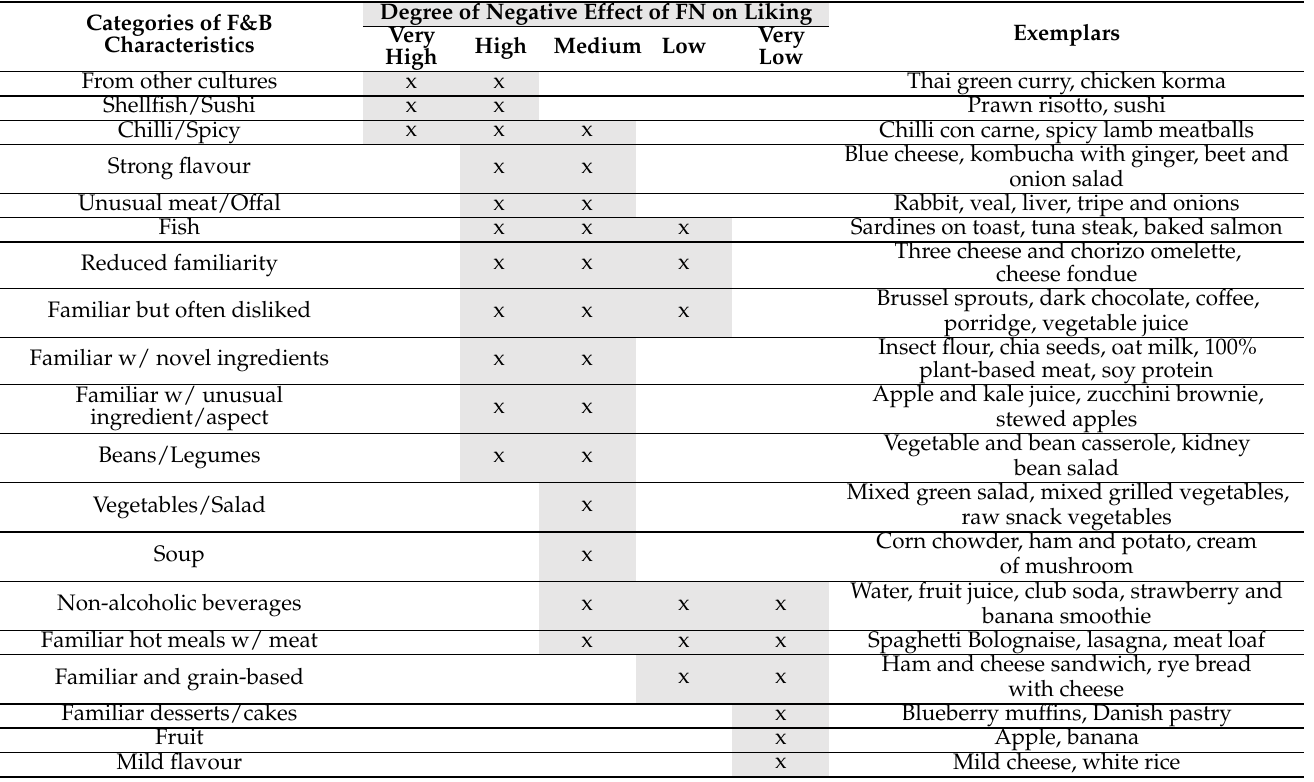
Table 3. Derived categories of F&B characteristics and their presence/absence in the five groups categorising the varying negative effect of FN of F&B liking (“very high”, “high”, “medium”, “low” and “very low”). The categories of F&B characteristics should be seen in the context of those above it and refer to F&B characteristics not previously captured. The exemplar F&B items illustrate the associated category of F&B item characteristics, but items may also fit into other categories without this being